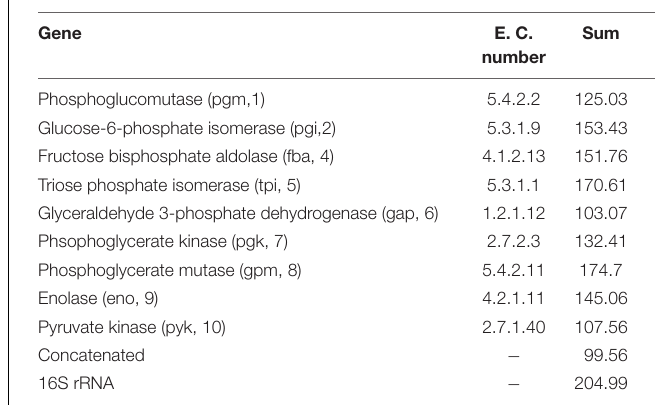
TABLE 2 | Sum of branch lengths for each